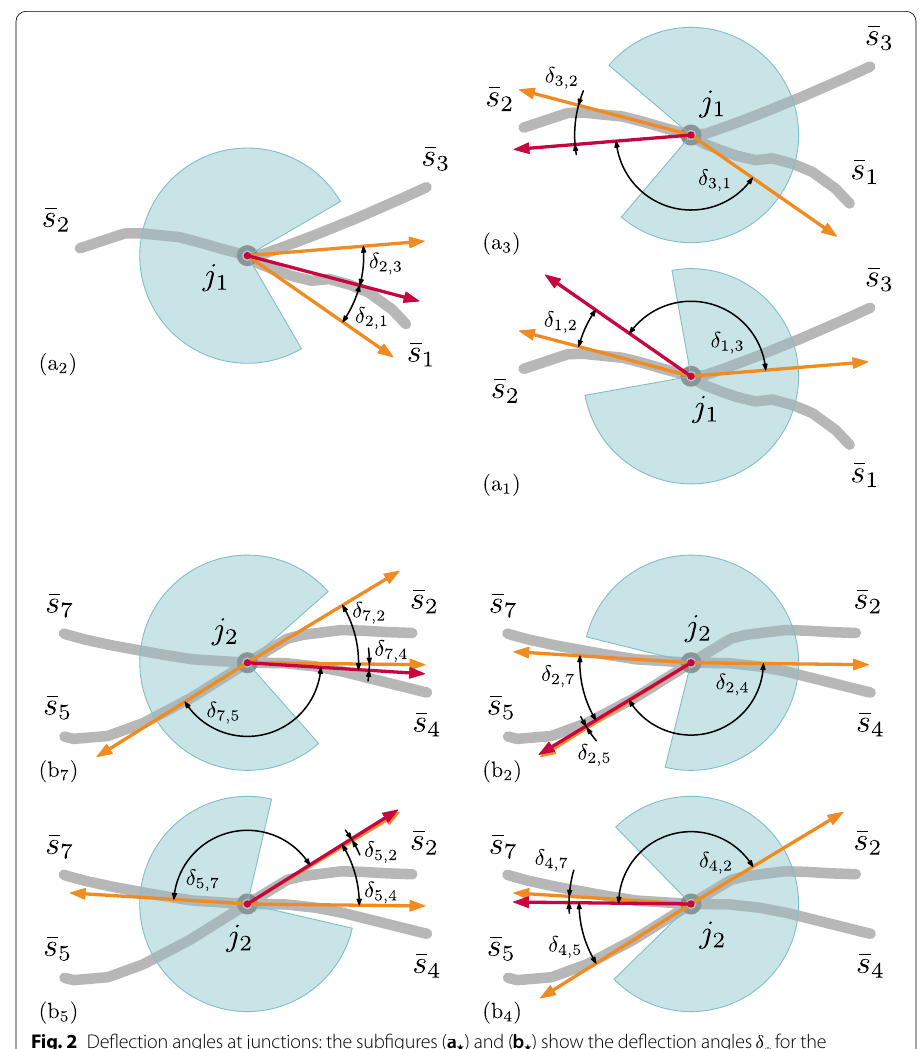
Fig. 2 Deflection angles at junctions: the subfigures ( a ⋆ ) and ( b ⋆ ) show the deflection angles δ ∗ for the junctions j 1 and j 2 , respectively, from the notional example in Fig. 1. A deflection angle of a street at a junction is basically the magnitude of the angular change experienced at the junction by the tangent of the street. In practice, the street can be arbitrarily oriented and the deflection angle becomes the magnitude of the angle between the incoming and outgoing tangents. The transposition to pairs of street-segments at junctions is obvious. Each subfigure corresponds to a possible incoming street-segment. The subfigures actually organize (index) themselves according to the cardinal direction (index) of their incoming street-segment. For each subfigure, the incoming tangent at the junction is in red and the outgoing tangents are in orange. Every double-arrow arc between the tangents of an incoming street-segments ¯ s i and an outgoing one ¯ s o indicates a deflection angle denoted by δ i , o —and has a radius linear with the supplementary angle π − δ i , o . Realistic angular changes are assumed to be bounded above. We have set the deflection angle threshold to π/ 4 . The light-blue pie areas identify the forbidden deflection angles—and have the radius of any arc with the deflection angle threshold as deflection angle. An incoming street-segment might so continue its way only along any outgoing street-segment whose tangent or arc lies within the angular sector of the missing slice—and/or does not cross the pie area. Furthermore, realistic configurations of streets must obviously have no street overlap. No incoming street-segment can continue its way along an outgoing street-segment already passed through. The very basic idea behind the state-of-the-art for building configurations of streets is a loop: commit one choice of outgoing street-segment; move to its opposite junction; repeat. Figure 3 along with supplementary Animation A1 (Additional file 1) illustrate how streets can emerge from this approach. In contrast, our approach identifies at every junction all the combinations of incoming and outgoing street-segments and “flips” them. Figure 4 sketches why and how these combinations are actually maximum matchings, while Fig. 5 along with supplementary Animation A2 (Additional file 2) illustrate a short sequence of